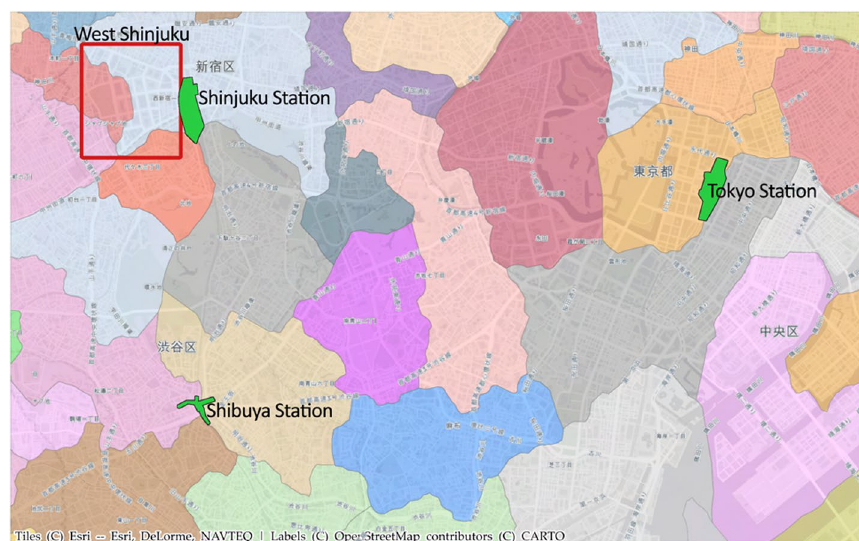
Fig. 7 Close-up map of the communities discovered using the greedy modularity algorithm without edge weights. Pictured area is 9.33 km wide by 5.6 km tall and covers the areas around Shinjuku, Shibuya, and